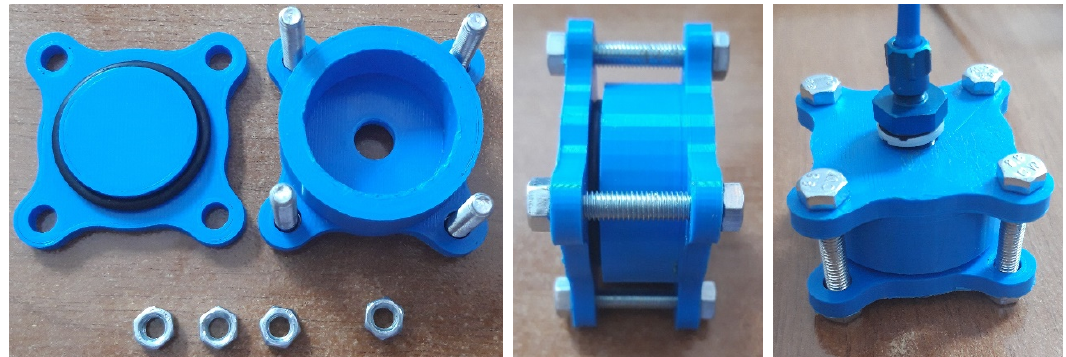
Figure 4. The preparation of the assembly to be connected to a pneumatic hose and tested submerged in the water con- tainer.